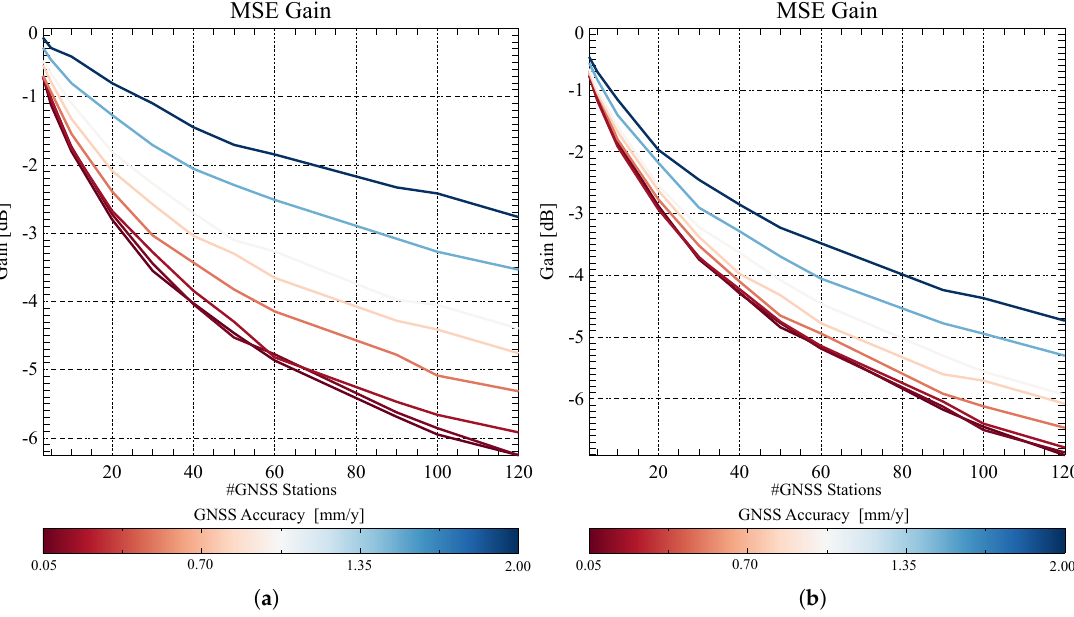
Figure 5. Performance simulations in retrieving (cid:98) δ carried out with different atmospheric noise sills: ( a ) σ 2 α = 2 mm 2 /y 2 and ( b ) σ 2 α = 9 mm 2 /y 2